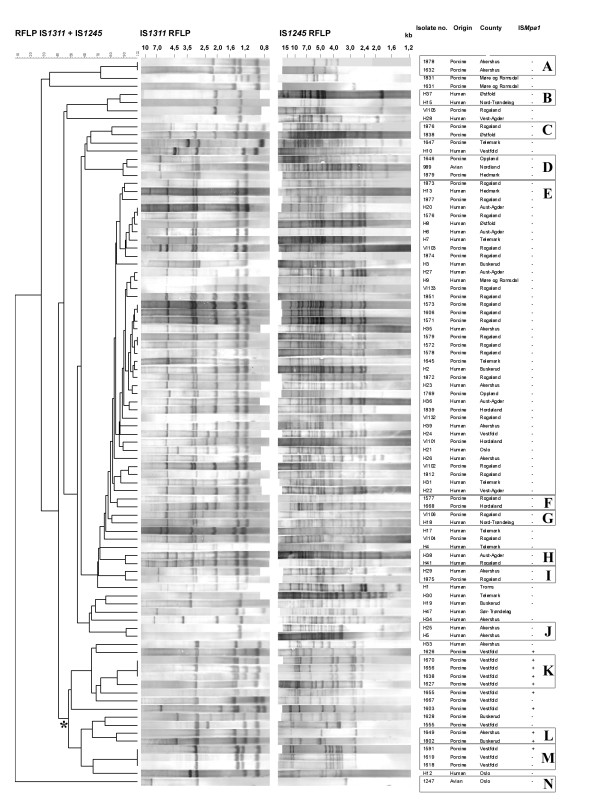
A dendrogram showing the cluster analysis of the composite dataset of RFLP experiments using IS1311 and IS1245 as probes. A total of 98 isolates of Mycobacterium avium from Norway are included. The dendrogram was calculated by using the similarity by the average from experiments and the unweighted-pair group method using arithmetic averages clustering method. Correction for internal weights was used. Laboratory numbers, host and county origin of the isolates and the result of the PCR of ISMpa1 are given in columns on the right. The branch that includes the ISMpa1 positive isolates is marked with an asterisk. A total of 14 clusters (defined by 80% similarity) are grouped in rectangular frames and labelled A-N. Cluster N, including nine avian isolates and the reference strain R13, are represented by isolate 1247.